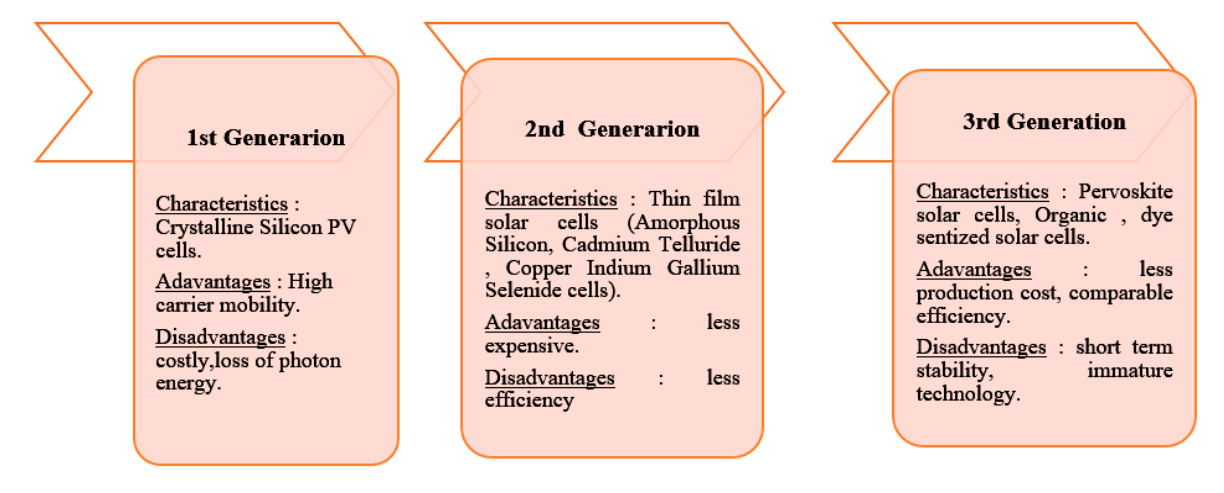
Figure 2. Generations of solar cells.